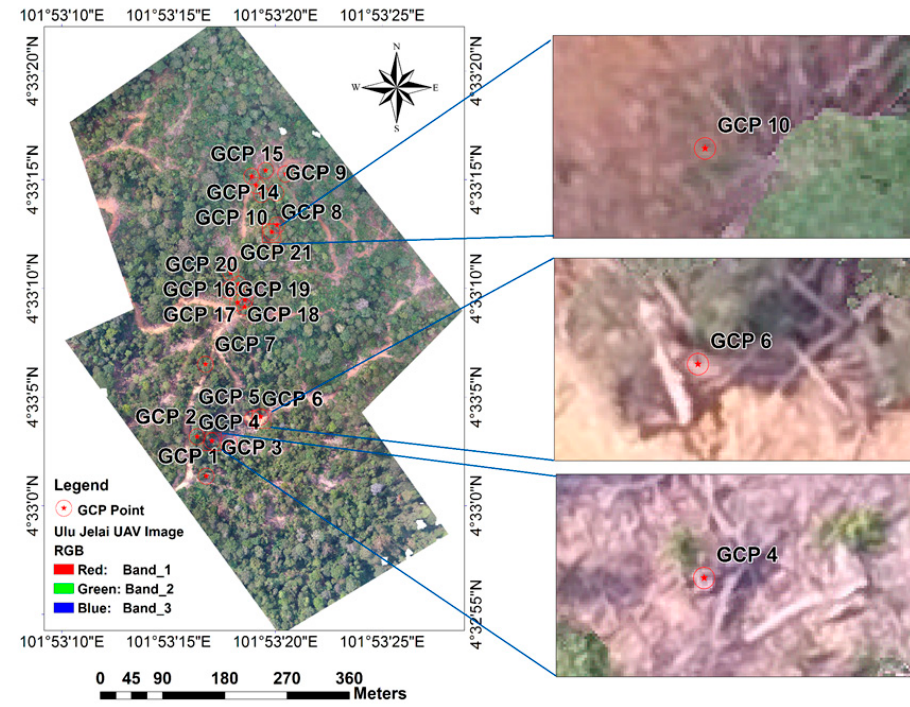
Figure 4. Ground control points distribution over UAV image in Ulu Jelai forest reserve .